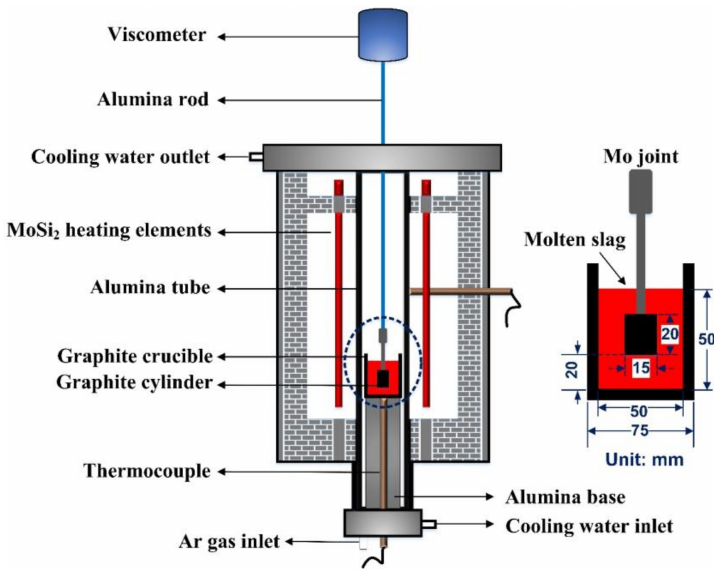
Figure 1. Schematic diagram for viscosity